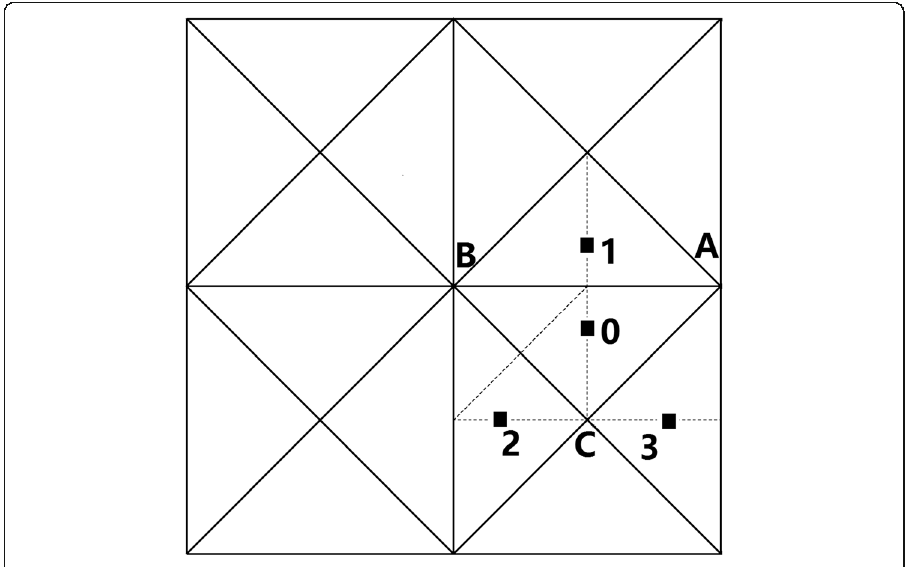
Fig. 6 Regular double-split triangular grid stencils ( AR = 1; reg. double-split tri.)